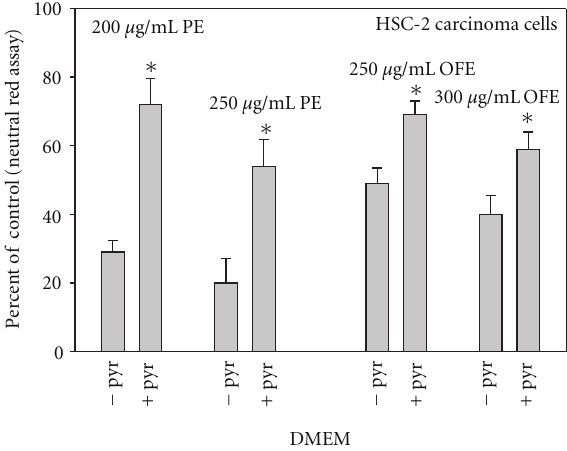
Figure 6: Comparative toxicities of pomegranate extract (PE) and olive fruit extract (OFE) towards human oral HSC-2 carcinoma cells, in Dulbecco’s modified Eagle medium (DMEM) commercially formulated without pyruvate ( − pyr) and with pyruvate (+pyr). Cell proliferation was quantified with the neutral red assay, a cell viability assay. Data are presented as the mean percent of control ± S.E.M. Data for pomegranate extract are from Weisburg et al. [14] and for olive fruit extract from Schuck (unpublished).